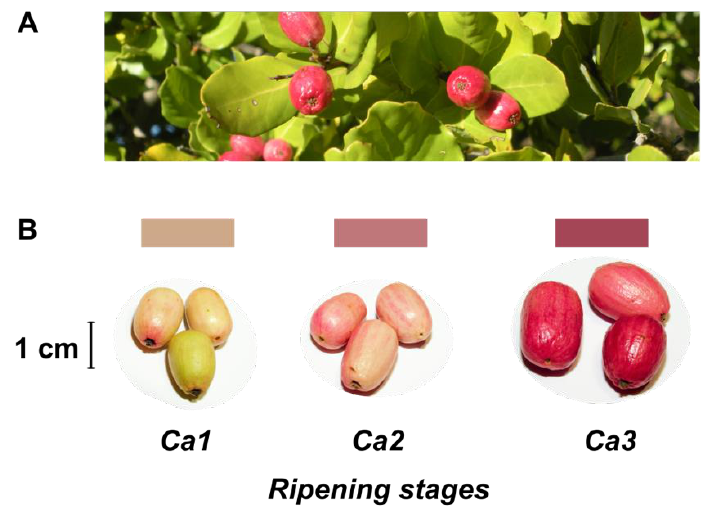
Figure 1. Leaves and fruits of peumo tree. ( A ) Leaves and fruits of peumo [ Cryptocarya alba (Mo- lina) Looser]; ( B ) Three different development stages of peumo fruit. Photography credit: Lida